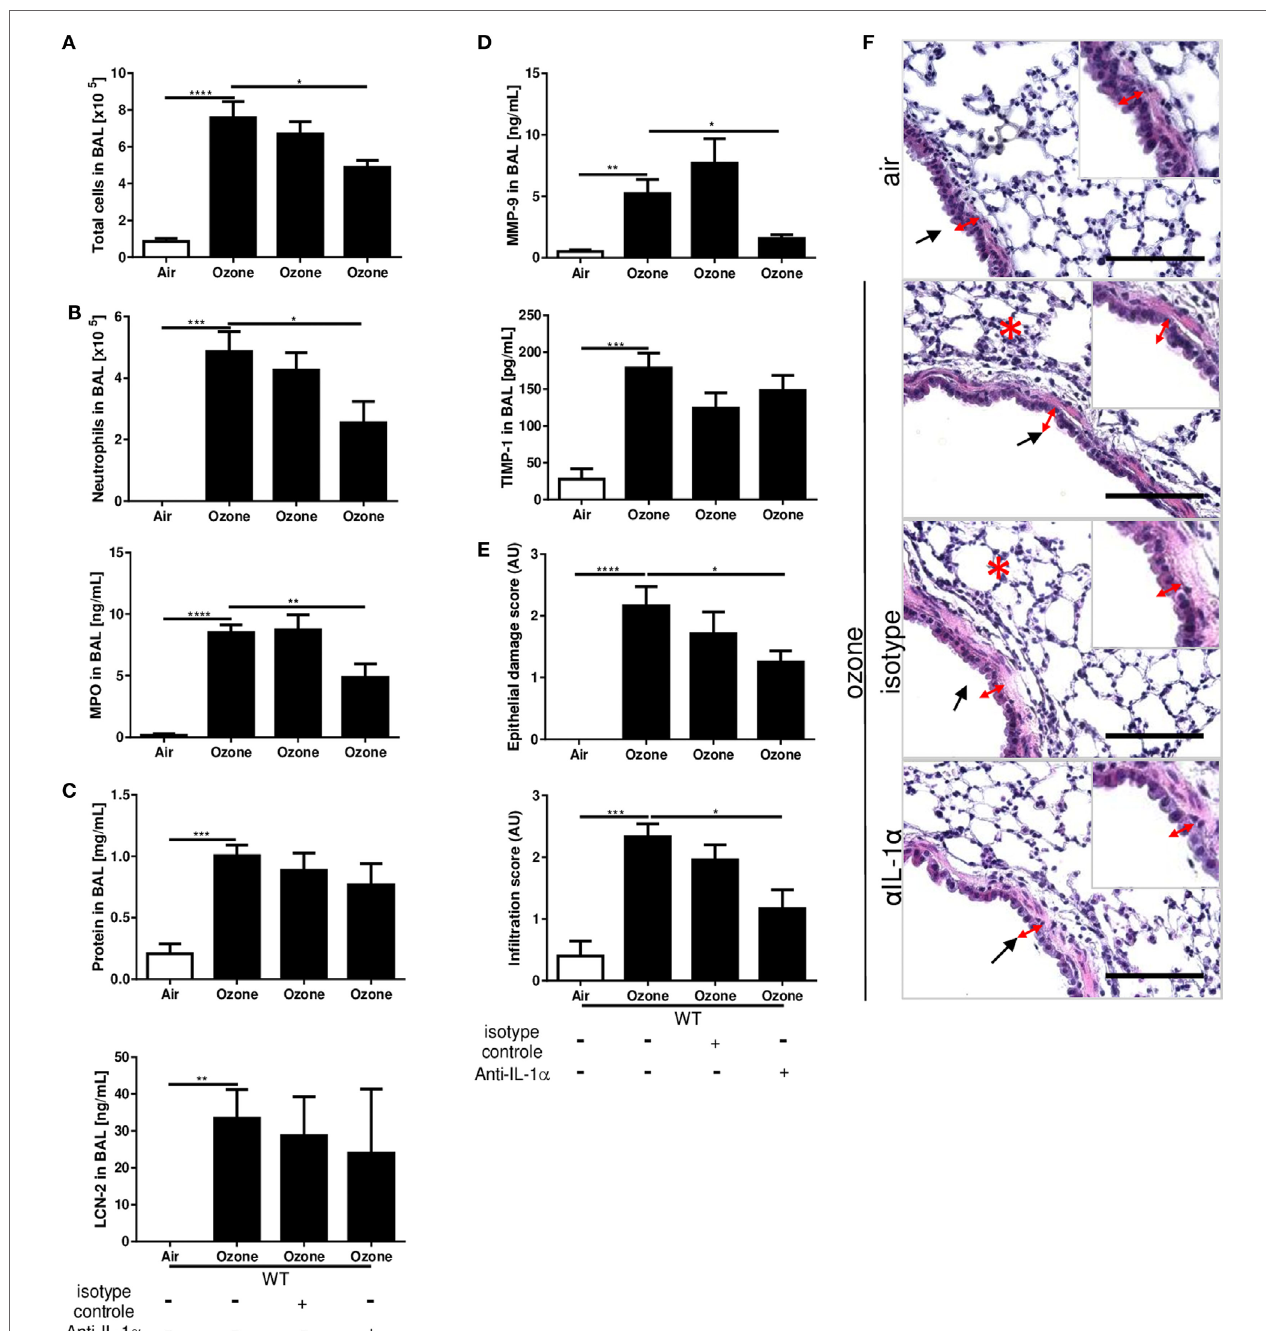
FigUre 3 | Interleukin-1 (IL-1) α antibody blockade reduces ozone-induced lung inflammation. A single administration of IL-1 α neutralizing antibody 12 h before ozone exposure in wild type mice reduced inflammatory parameters. Total cell (a) , neutrophils (count and myeloperoxidase) (B) , total proteins and lipocalin-2 (c) , matrix metalloproteinase 9, and tissue inhibitor metalloproteinase 1, (D) and histology with epithelial damage and inflammatory score (e) , associated with histological picture (F) , scale bar = 100 µm, 24 h after ozone exposure. Representative data of two-independent experiments are shown. Results are expressed as mean ± SEM and are from one experiment, with n = 5–6. Statistical test: ordinary one-way ANOVA, with Bonferroni post test, p value: **** < 0.0001, *** < 0.001, ** < 0.01, * <